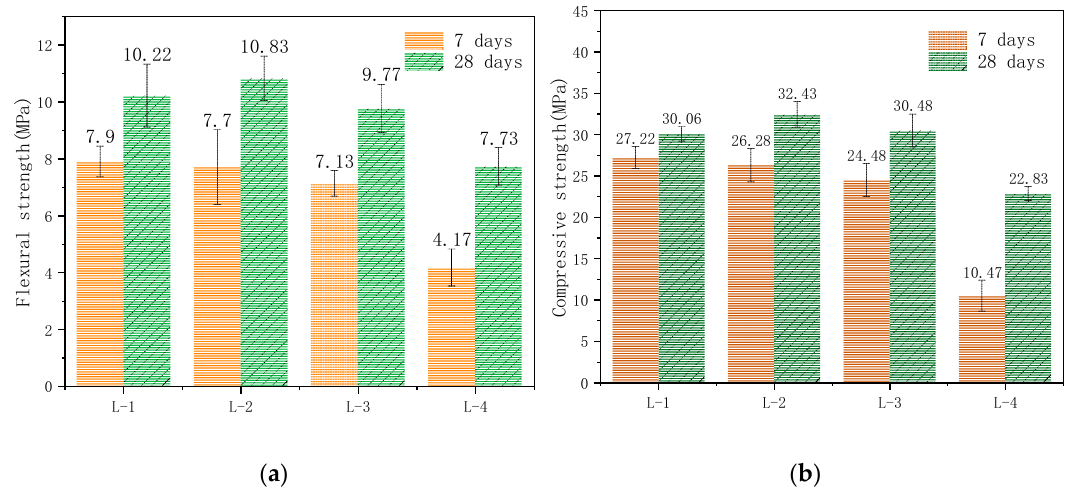
Figure 5. The curve of ( a ) flexural strength and ( b ) compressive strength for concrete prepared with RM and YPS partially substituting ordinary Portland